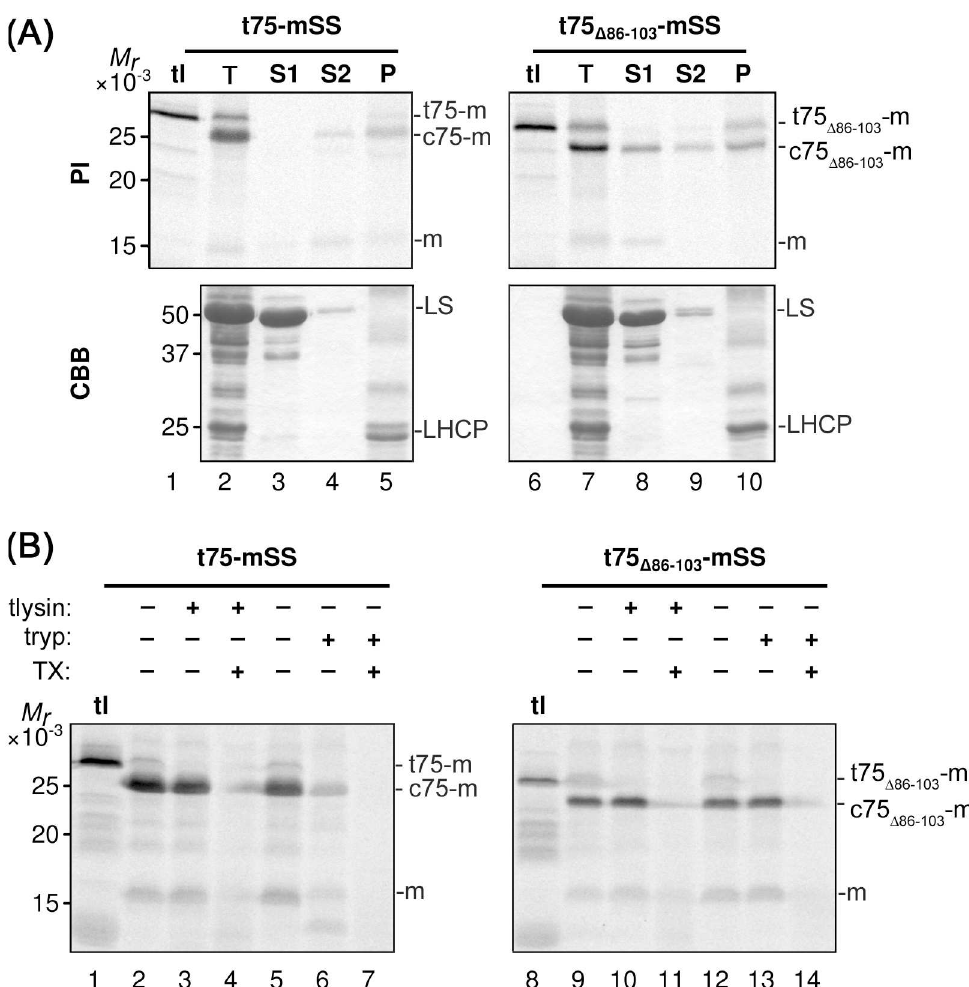
Fig 2. In vitro import of t75-mSS variants. (A) Radiolabeled t75-mSS variants indicatedabove were incubated with isolated chloroplasts under the import condition. After 30-min of import, intact chloroplasts were reisolated and separated into two aliquots. The first aliquot was kept as total chloroplasts (T). The second aliquot was hypotonically lysed and fractionated by centrifugation to a supernatant (S1) and the pellet. The pelletwas then resuspended with 0.1M Na 2 CO 3 and fractionated by centrifugation to the second supernatant (S2) and the final pellet fraction (P). Samples equivalent to 3 μ g chlorophyll were separated by SDS-PAGE, and radiolabeled proteins and total proteins in each sample were visualizedby phosphorimaging(PI) and Coomassie BrilliantBlue staining(CBB), respectively.The experiments were doneconcurrentlywith those shown in Fig 3A and S1 Fig. tl containedthe translationproduct corresponding to the one used for the import assay with 3 μ g chlorophyll- equivalent chloroplasts. The precursors containing the entire t75 variants, the intermediates that carryingthe c75 variants, and the mature forms lacking the entire t75 variant, respectively, are indicatedat right; mSS is indicated with the letter m. For the CBB panel,large subunitof ribulose-1,5-bisphosphate carboxylase/oxygenaseand light-harvesting chlorophyll a/b-bindingprotein are indicatedas LS and LHCP, respectively.(B) After the import reaction as describedin the legendto panel (A), intact chloroplasts were reisolatedand separated into six aliquots.Three of them were resuspended in import buffer containing1 mM CaCl 2 with or without 1 μ g thermolysin(tlysin) per μ g chlorophyllequivalent chloroplasts and 1% Triton X-100 (TX) as indicated, incubated for 30 min on ice in the dark. Other three aliquotswere resuspended in import buffer with or without 0.5 μ g trypsin (tryp) per μ g chlorophyll equivalentchloroplasts and 1% Triton X-100 (TX) as indicated,incubatedfor 60 min at room temperature in the dark. The activities of thermolysin and trypsin were quenchedby 10 mM EDTA and 10 μ g trypsin inhibitorper μ g trypsin, respectively.Samples equivalent to 3 μ g chlorophyll were separated by SDS-PAGE and radiolabeled proteins visualizedby phosphorimaging. The experiments were done concurrently with those shown in Fig 3B and S2 Fig. For the labels at right, see the legendto panel (A).